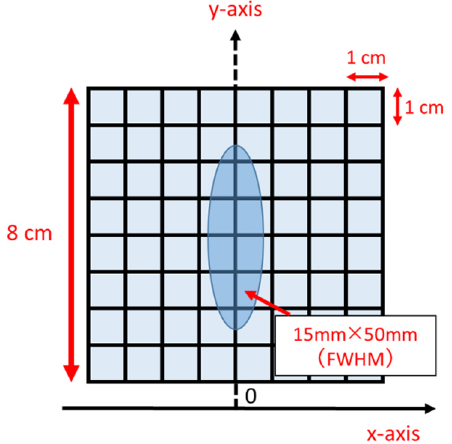
Figure 3. Conceptual front view of the fly-eye lens.